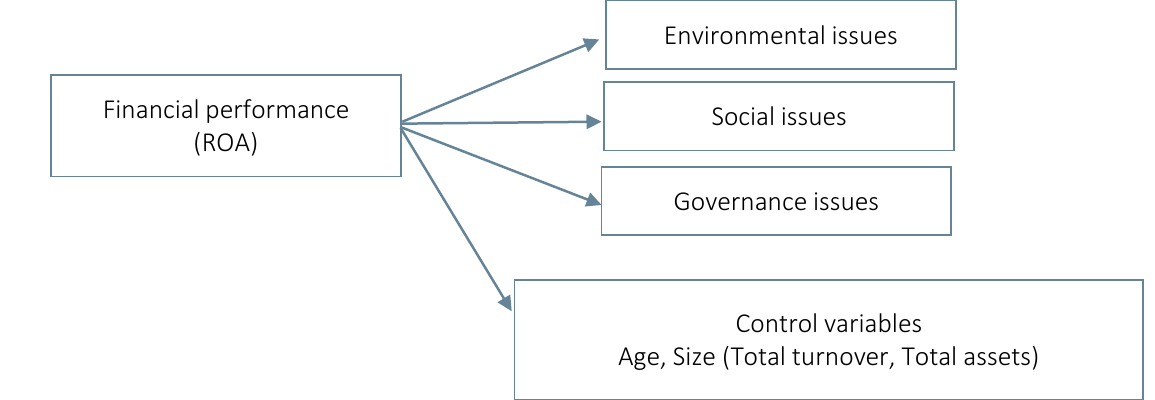
Figure 1. Conceptual framework